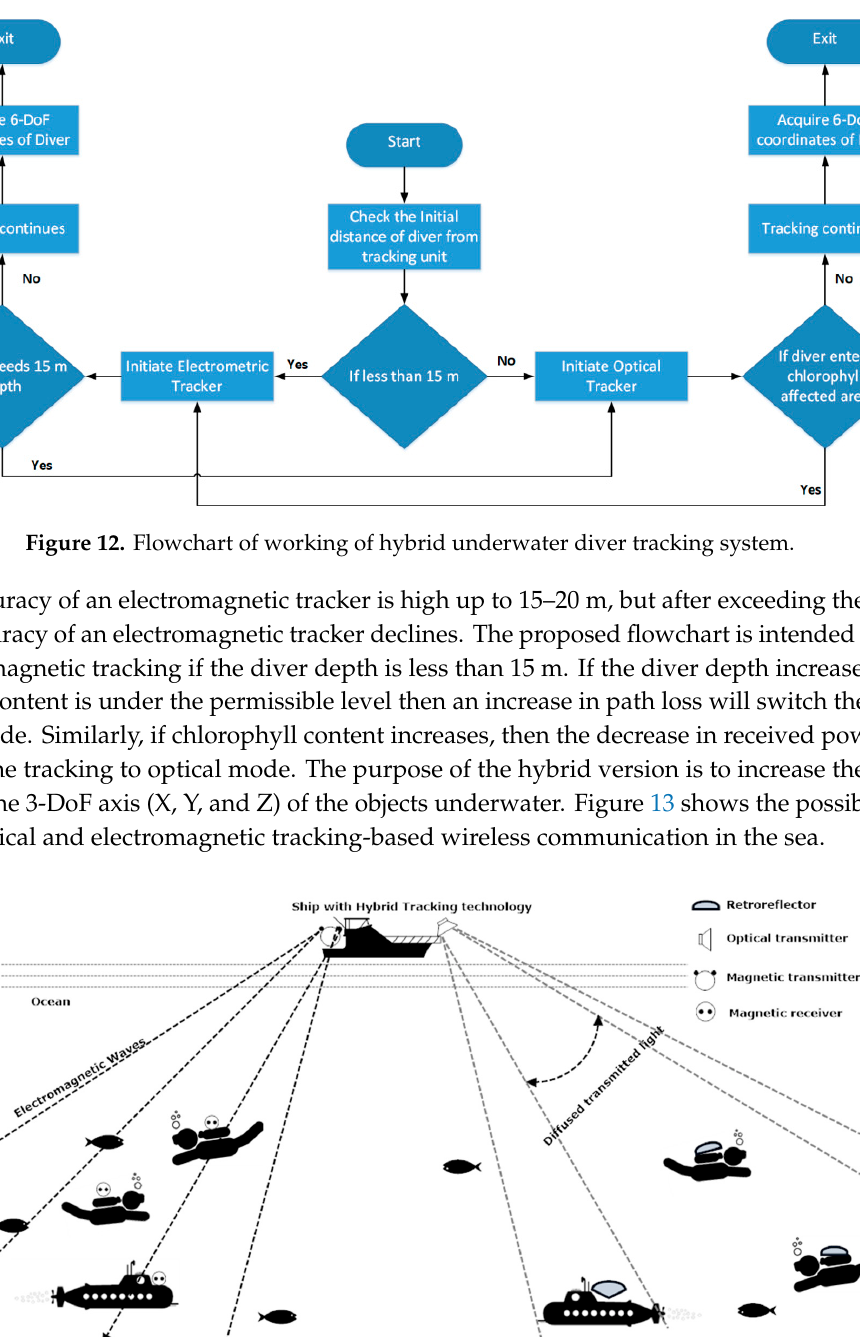
Figure 14. Data rate of the hybrid tracking system and electromagnetic tracking system. The channel capacity of the electromagnetic tracker is given by Equation (15) [49]. 𝐶 (cid:3032)(cid:3045)(cid:3034) = 𝐸 (cid:4674)(cid:1516) 𝑙𝑜𝑔 (cid:2870) (cid:4672)1 + (cid:3020) (cid:3299) ((cid:3033))|(cid:3009) (cid:3293) ((cid:3033))| (cid:3118) (cid:3015) (cid:3116)